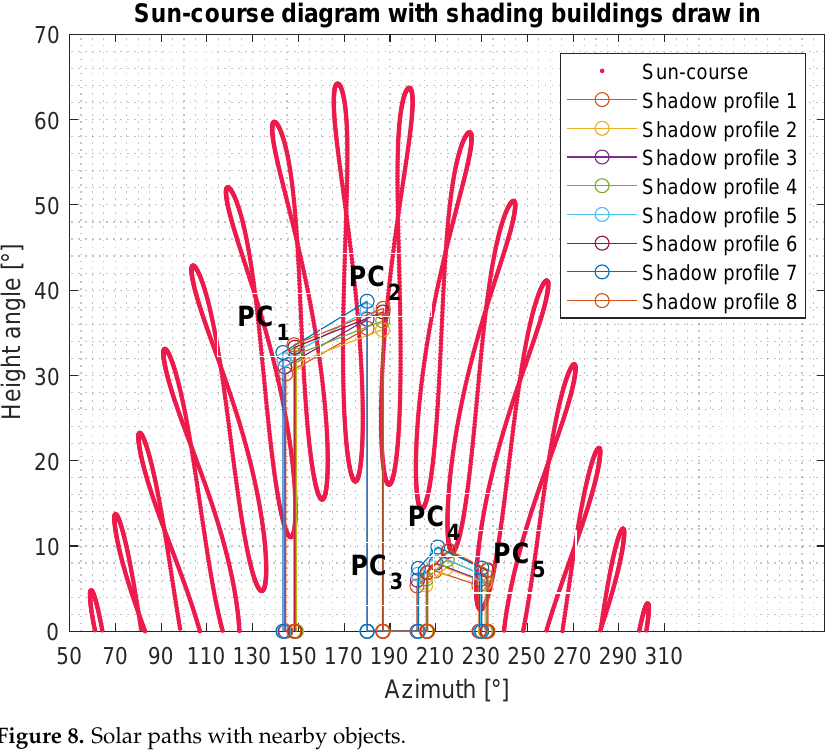
Figure 8. Solar paths with nearby objects.